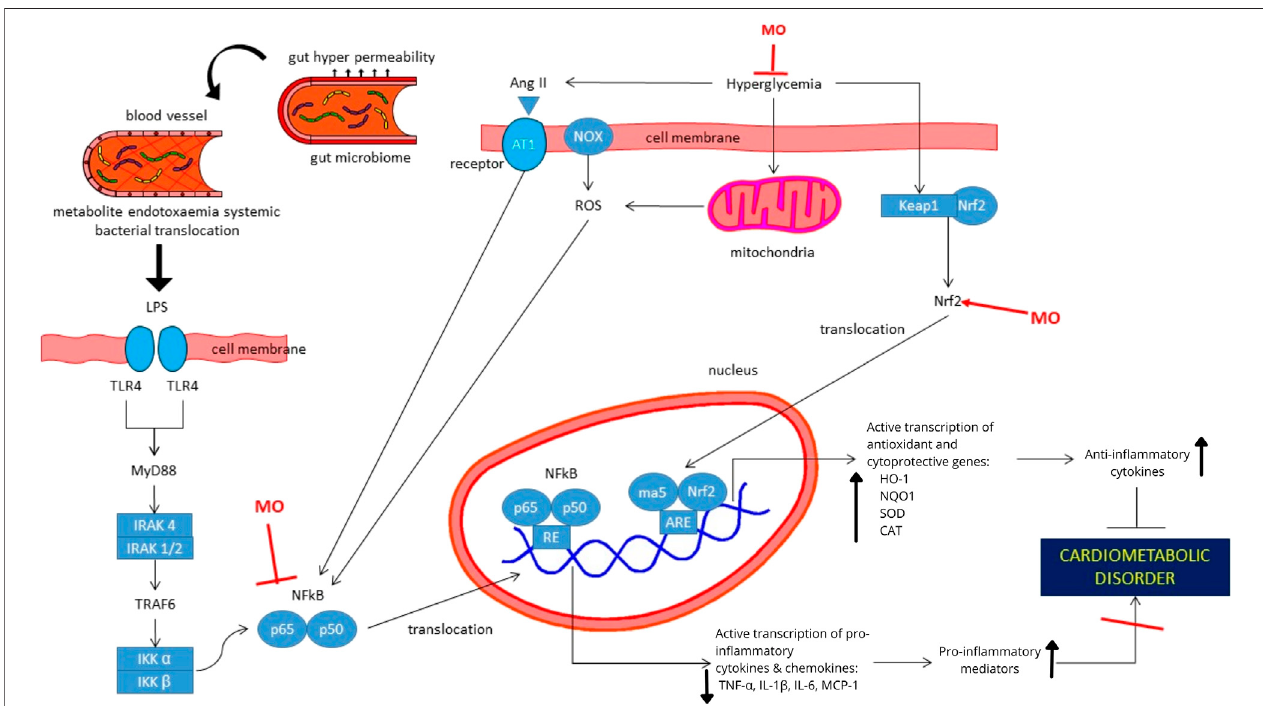
FIGURE 2 | Proposed mechanism of actions of Moringa oleifera extracts or its isolated compounds for the treatment of cardiometabolic-related disorders. Antioxidative and anti-in fl ammatory activities ofMO are mainly responsible for its action in hyperglycemia, hypertension, dyslipidemia and obesity. MO upregulates Nrf2, which resulted in the increased transcription of antioxidative and cytoprotective genes. Further, the process increases anti-in fl ammatory cytokines. In addition, MO provides its anti-in fl ammatory effects by suppressing NF-kB protein and its translocation to the nucleus, which resulted in downregulation of pro-in fl ammatory genes. Suppressive effects of MO to NF-kB can be resulted from direct downregulation in NF-kB or indirect effect due to the change in intestinal tissue integrity and gut microbiome composition and functions. Abbreviation: MO, Moringa oleifera; Ang-II, Angiotensin II; AT1, Angiotensin 1; CAT, catalase; HO-1, Heme oxygenase-1; IKK α , Inhibitory kB kinase alpha; IKK β , Inhibitory kB kinase beta; IRAK, Interleukin-1 receptor associated kinase; Keap1, Kelch-like ECH associated protein 1; LPS, lipopolysaccharides; MCP-1, Monocyte chemoattractant protein; MyD88, Myeloid differentiation primary response protein; NOX, NADPH-oxidase; NQO1, NAD(P)H quinone dehydrogenase; Nrf2, Nuclear factor erythroid 2-related factor 2; ROS, Reactive oxygen species; SOD, sodium dismutase; TLR4, Toll-like receptor 4; TNF α , Tumor Necrosis